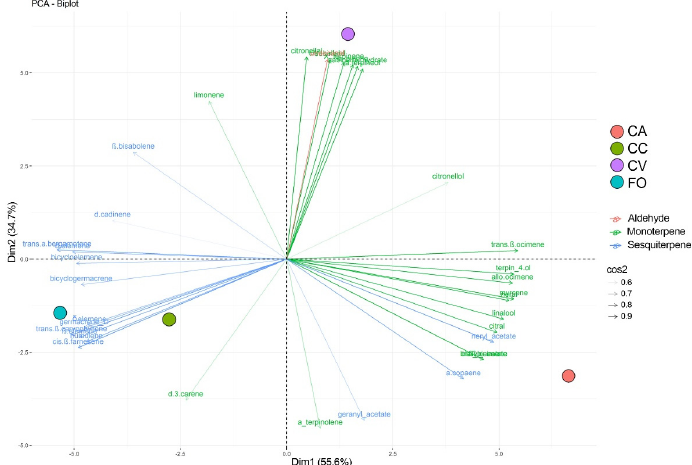
Figure 1. Biplot of the principal component analysis (PCA) for VOC profiles detected on Citrus varieties showing different susceptibilities to CTV infection. Based on their profiles, samples were organized in four groups, and the associated compounds to varieties separation are indicated by vectors in the plot, underlining their significance values (0.6 < cos2 < 0.9). Each main category is highlighted with a different color: aldehyde (red), monoterpene (green), and sesquiterpene (blue). CV: Citrus volkameriana ; FO: Forner-Alcaide no. 5; CC: Carrizo citrange; CA: Citrus aurantium .